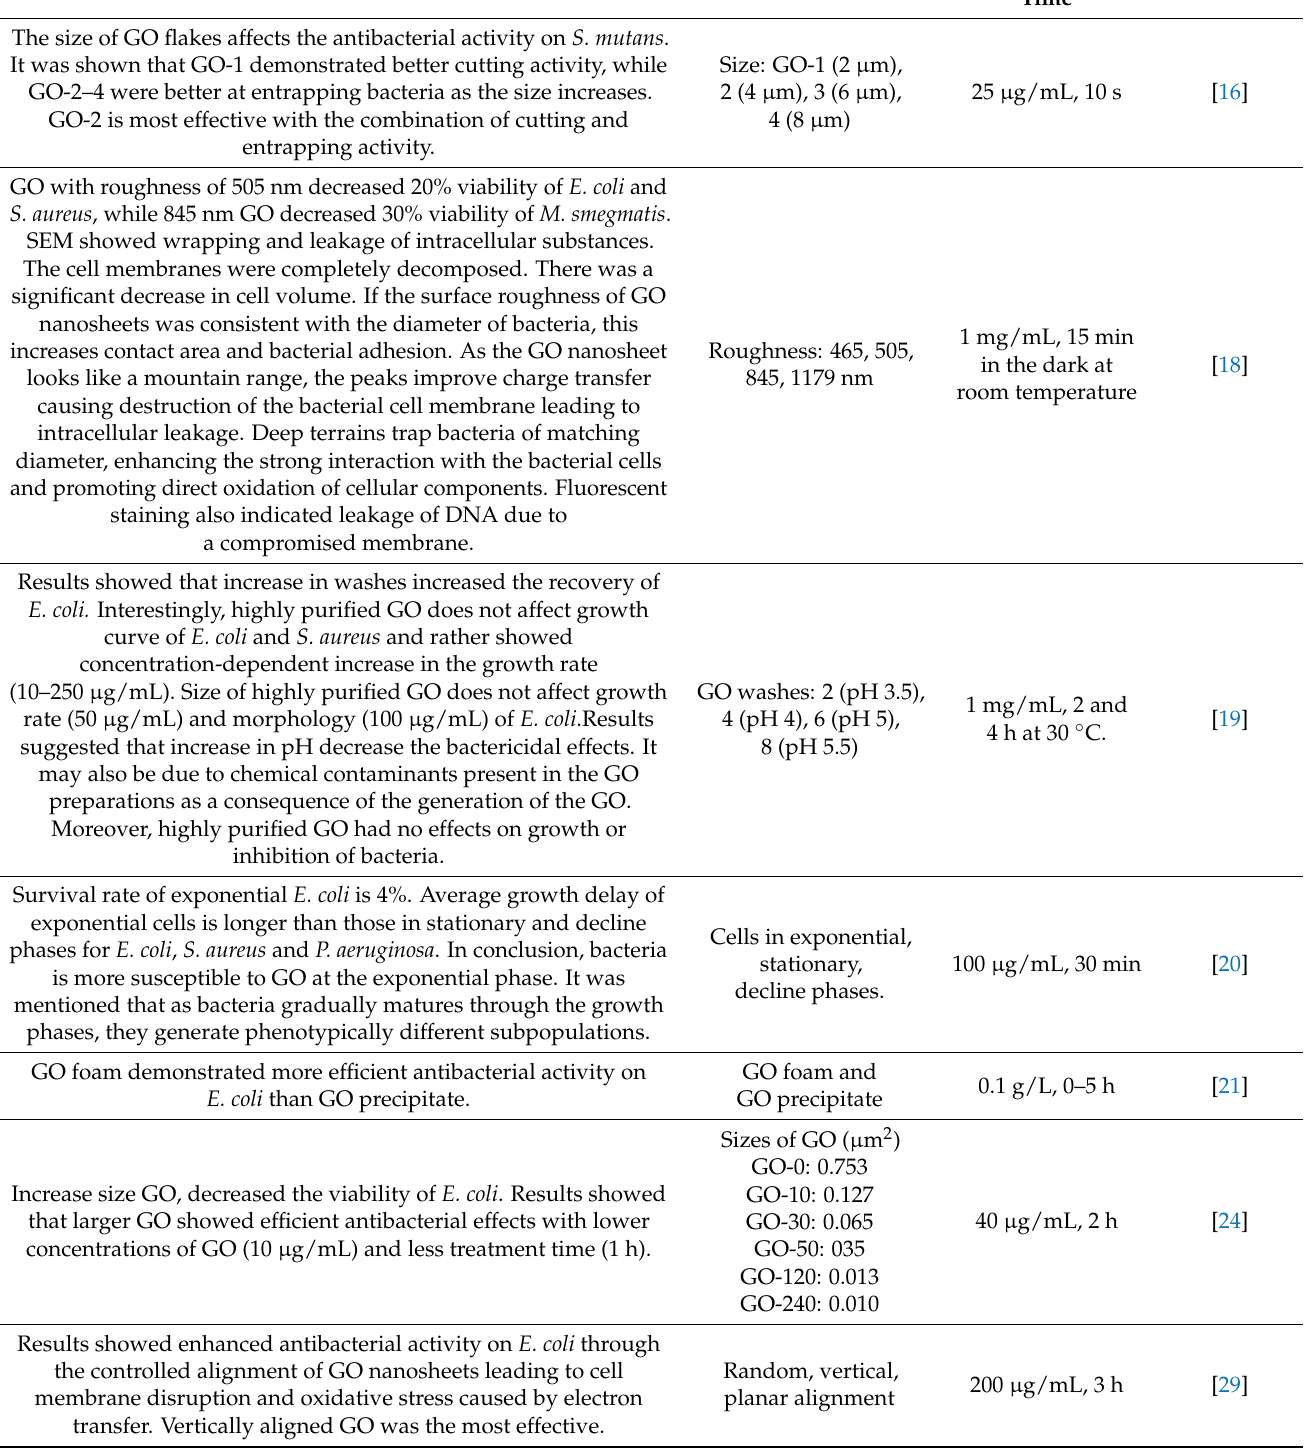
Table 2. Antibacterial activity exhibited by GO depends on its physicochemical properties. Findings Nature of GO